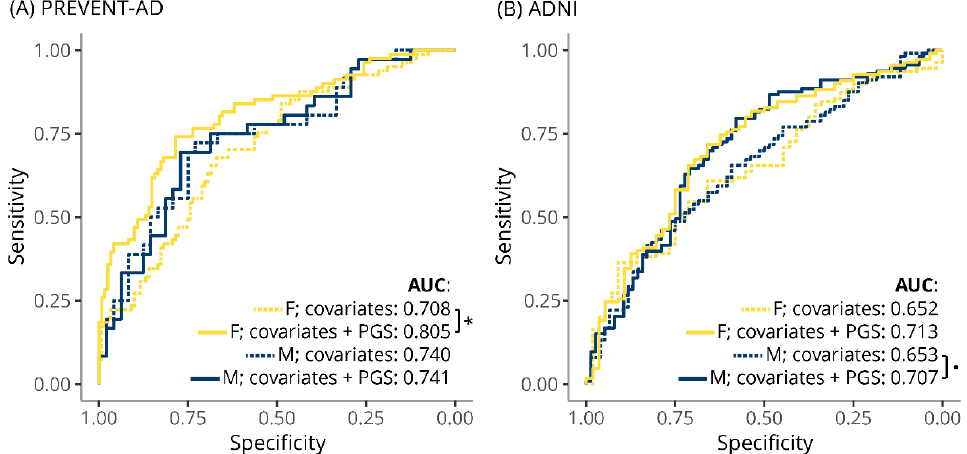
Figure 2. Effect of TC-PGS on prediction of hypercholesterolemia. ROC curves showing the effect of covariates and TC-PGS on predicting hypercholesterolemia in ( A ) PREVENT-AD and ( B ) ADNI, stratified for sex. Individuals were deemed hypercholesterolemic if they were on statins or TC levels > 6.2 mM (i.e., 240 mg/dL). Covariates included were genetic PCs 1–10, age, and age 2 . * p < 0.05, • p < 0.1Abbreviations: AUC, area under the curve; F, females; M, males; PC, genetic principal compo- nent; ROC, receiver operator characteristics; TC-PGS, total cholesterol polygenic score.